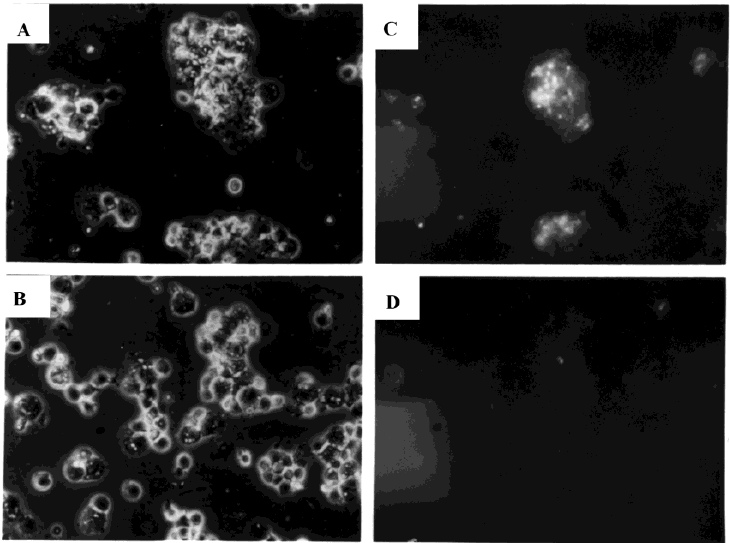
Figure 7. Expression of influenza A hemagglutinin (HA) by PHA-stimulated human PBMC (40× image). Influenza virus (H1N1)-exposed PBMC (upper panels, ( A , C )) and sham-exposed PBMC Figure 6. Cell cluster formation by sham-exposed and influenza virus-exposed PBMC (10× image). (lower panels, ( B , D )) were examined by light (left panels) and fluorescence microscopy (right panels; PBMC were sham-exposed ( A – D ) or exposed to influenza virus ( E – H ). Cultures were stained and same fields as left) after indirect immunofluorescent staining using influenza H1-specific polyclonal examined by light microscopy at 40× after 1 h ( A , E ), 4 h ( B , F ), 24 h ( C , G ), and 72 h ( D , H ). reference antisera. Cells were examined six hours after exposure to virus (MOI = 10). Representative fields are shown.